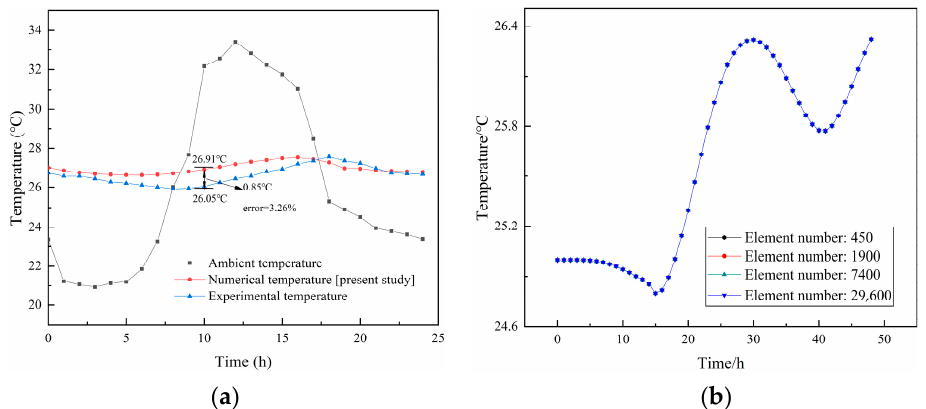
Figure 4. The numerical validation and mesh independence of physical model [39]. ( a ) Numerical validation. ( b ) Mesh independence.